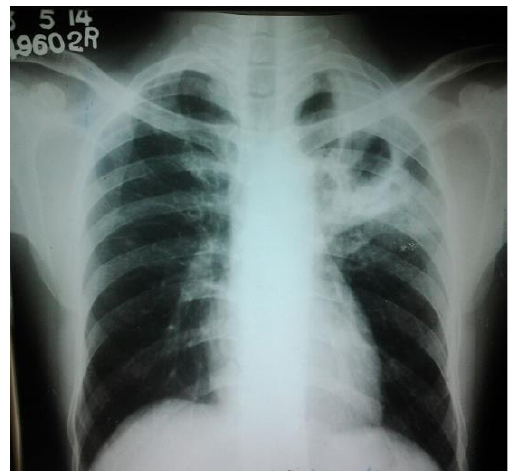
Figure 2. Chest radiography showing significant resolution of the pulmonary